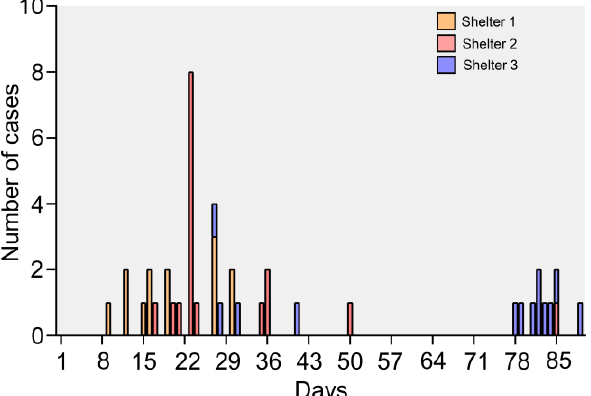
Figure 1. Epidemic curve showing dates of illness onset for cat vomiting and diarrhea cases in outbreak in three shelters from November to January.